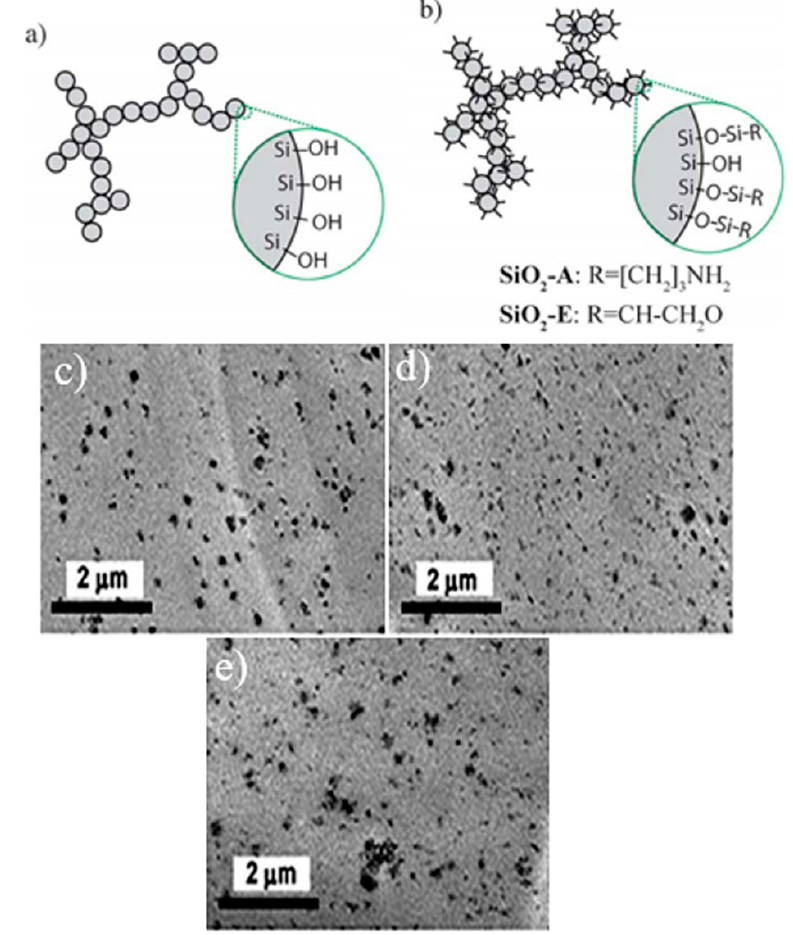
Figure 1. Schematic representation of the ( a ) surface-unmodified silica and ( b ) surface-modified silica aggregate. ( c – e ) TEM images of the PLA composites containing ( c ) un-modified SiO 2 , ( d ) SiO 2 -A, and ( e ) SiO 2 -E [26].